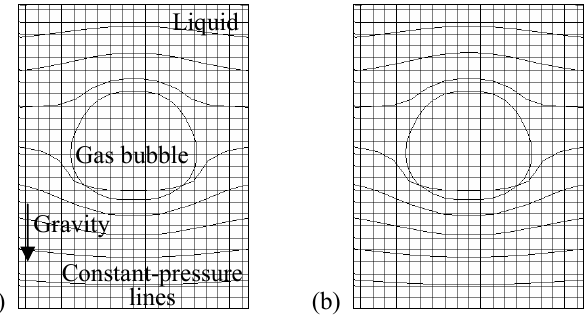
Physically appropriate momentum transport with improved formulation: (a) time level n, (b) time level n+1